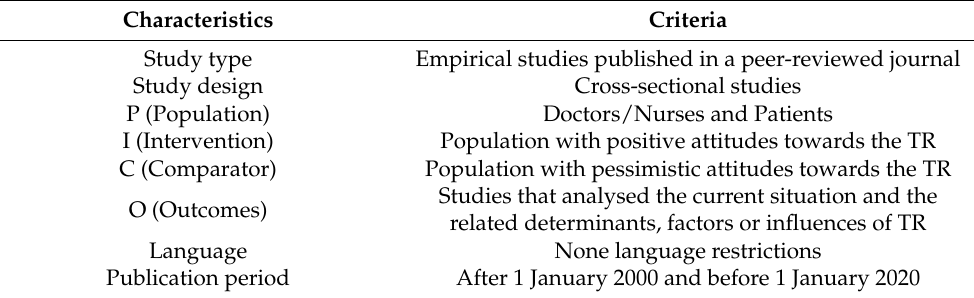
Table 1. Characteristics of selection